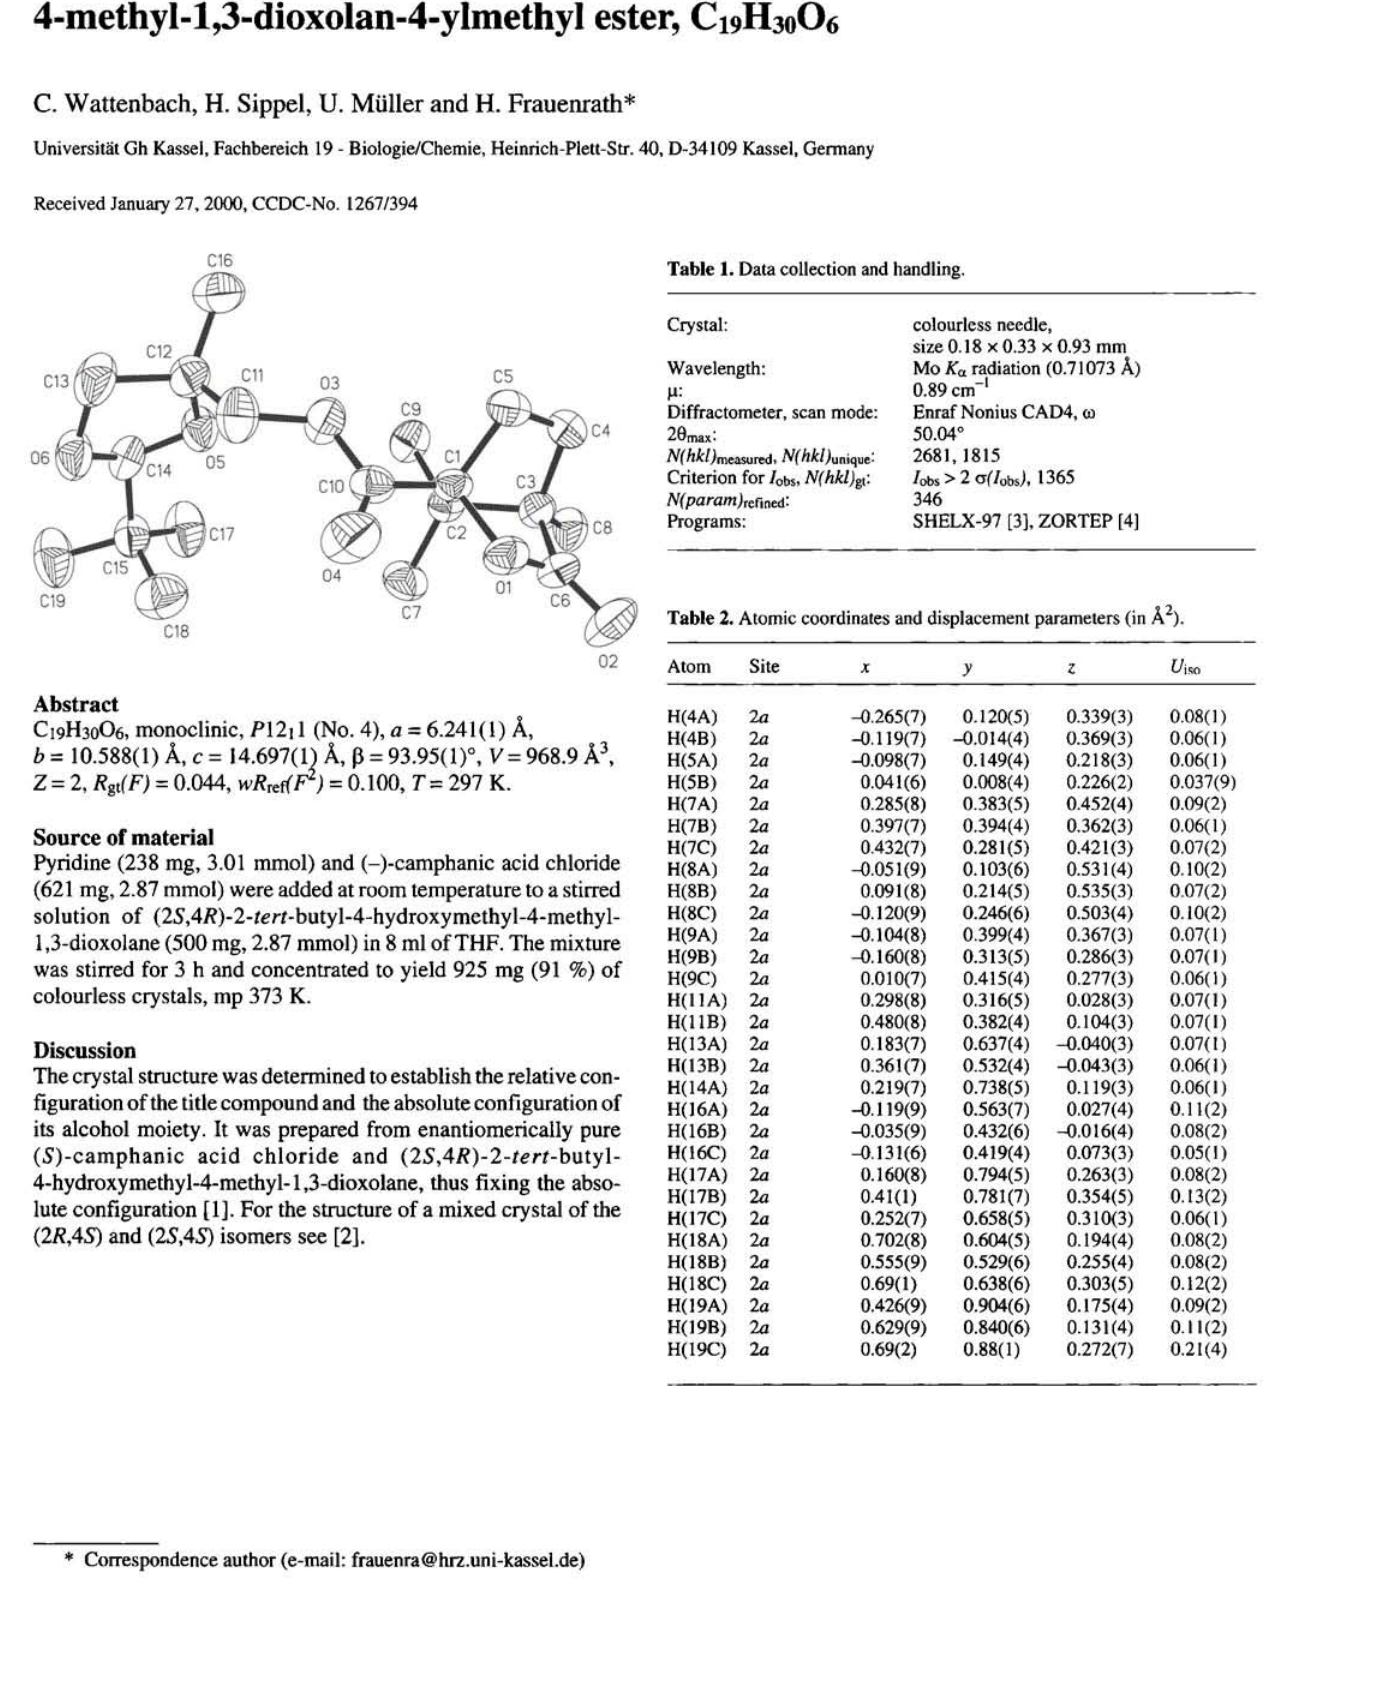
Table 2. Atomic coordinates and displacement parameters (in Â 2